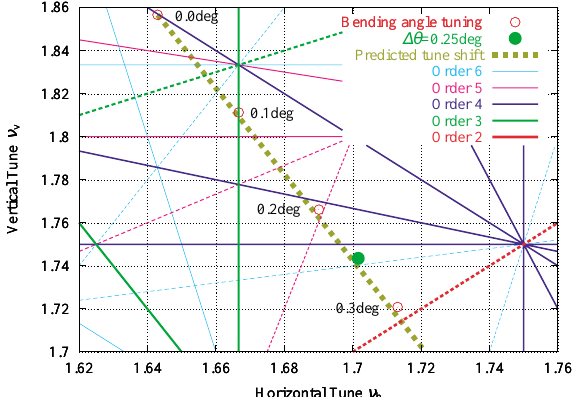
FIG. 6. (Color) Du dependence of tune values with resonance lines up to the sixth order. The solid lines and the dashed lines show the sum and differential resonance lines, respectively.